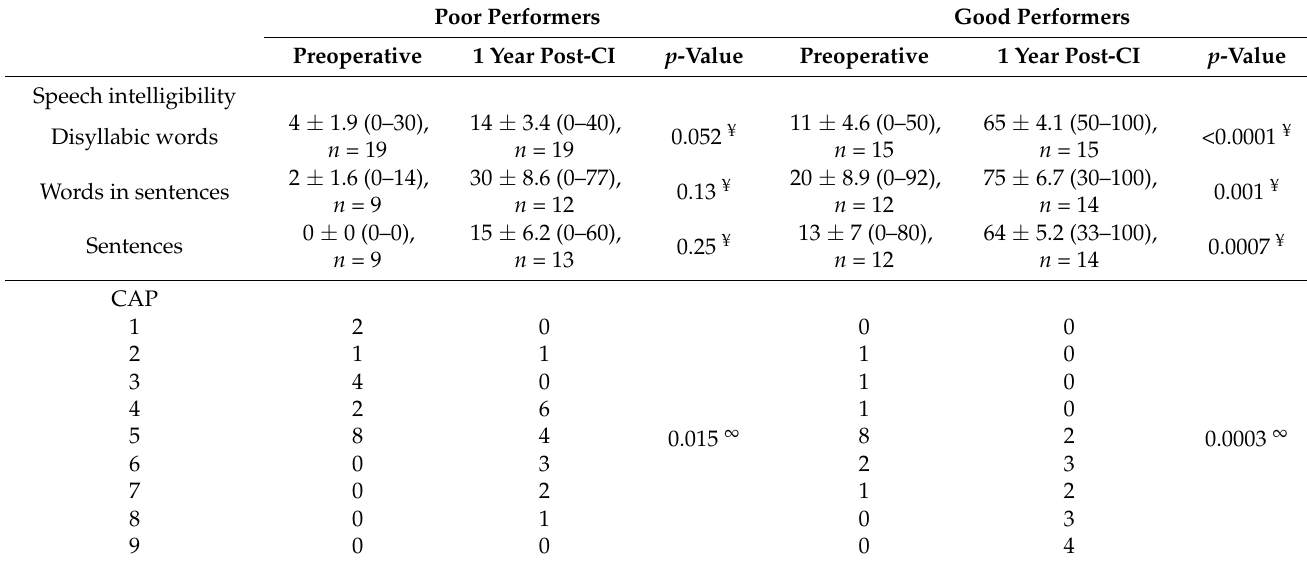
Table 2. Auditory performance in quiet with cochlear implant alone (best or first implanted ear for bilateral simultaneous or sequential implantation, respectively) and communication performance before and 1 year post-implantation in the two groups. Poor Performers Good